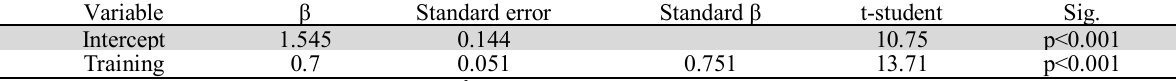
The summary of regression model between perceived organizational change and training Variable β Standard error Standard β t-student Sig. Intercept 1.545 0.144 10.75